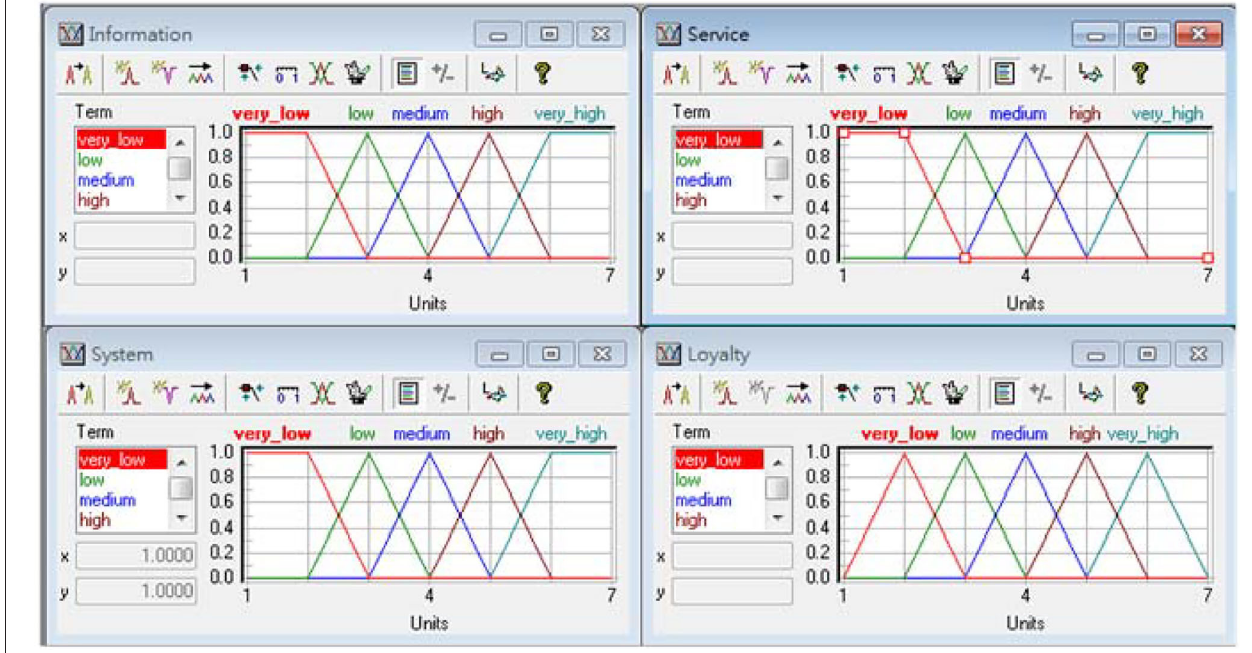
FIGURE 5 | Member